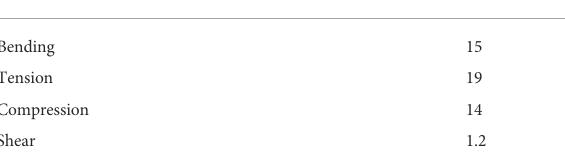
TABLE 3 Allowable Strength Design (ASD) for Guadua Members (Ministry of Urban Development and Housing, 2015b). Allowable